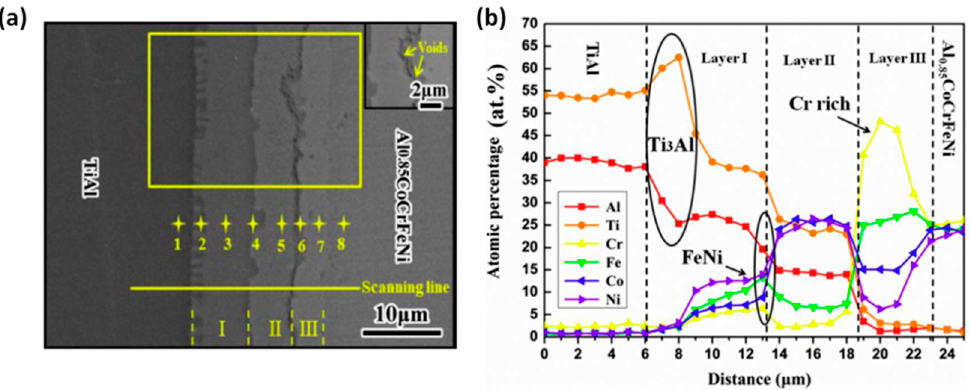
Figure 12. Characterization of the diffusion bonded TiAl/Al0.85CoCrFeNi joints using 950 °C/1 h/30 MPa: ( a ) microstructure under SEM; ( b ) Compositional element distribution taken from the scanning line region (Adapted from [92], with permission from Elsevier, 2020).